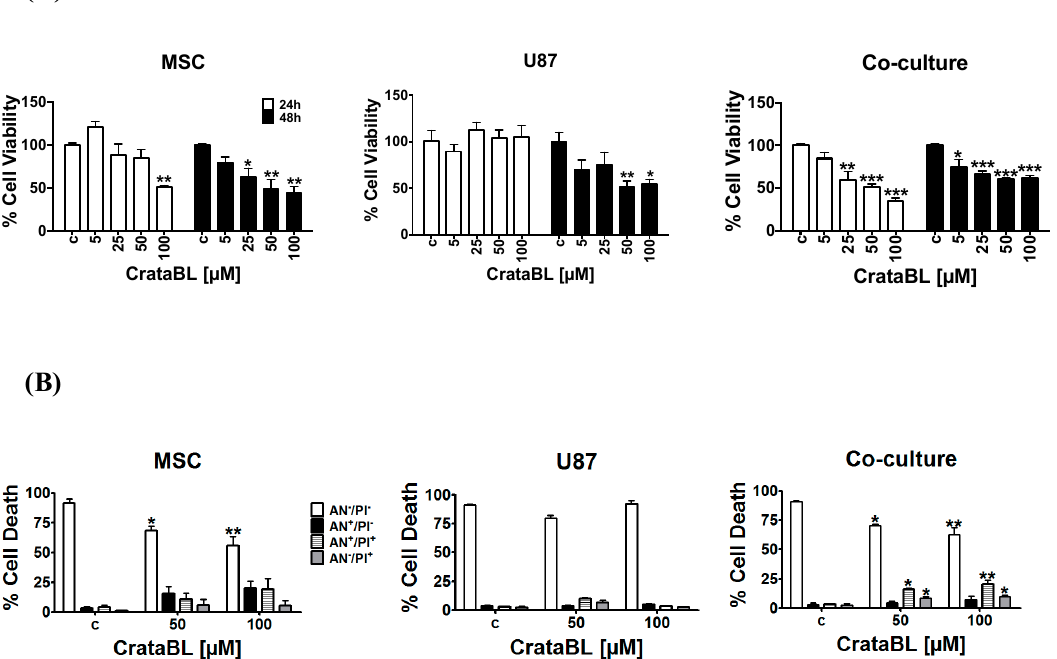
Figure 1. Effects of CrataBL on the cell viability and cells death of MSCs, U87 cells, and cocultured cells. Cell viability was measured by MTT assay at increasing concentrations of the inhibitor CrataBL at 5 µM, 25 µM, 50 µM, and 100 µM concentrations after 24 and 48 h of treatment. The absorbance values were normalized to nontreated control cells (c), as described in the Methods section. Panels represent ( A ) MSC, U87 glioblastoma cells, and direct cocultures. Cell death ( B ) was evaluated by flow cytometry as described in the Methods section, in MSC, U87 cells and cocultures after 24 h of CrataBL treatment. AN − /PI − represent viable cells; AN + /PI − represent early apoptotic; AN + /PI + and AN − / PI + represent late apoptotic and necrotic cells. Significance among experimental groups was considered as * p < 0.05, ** p < 0.005, and *** p < 0.0005.